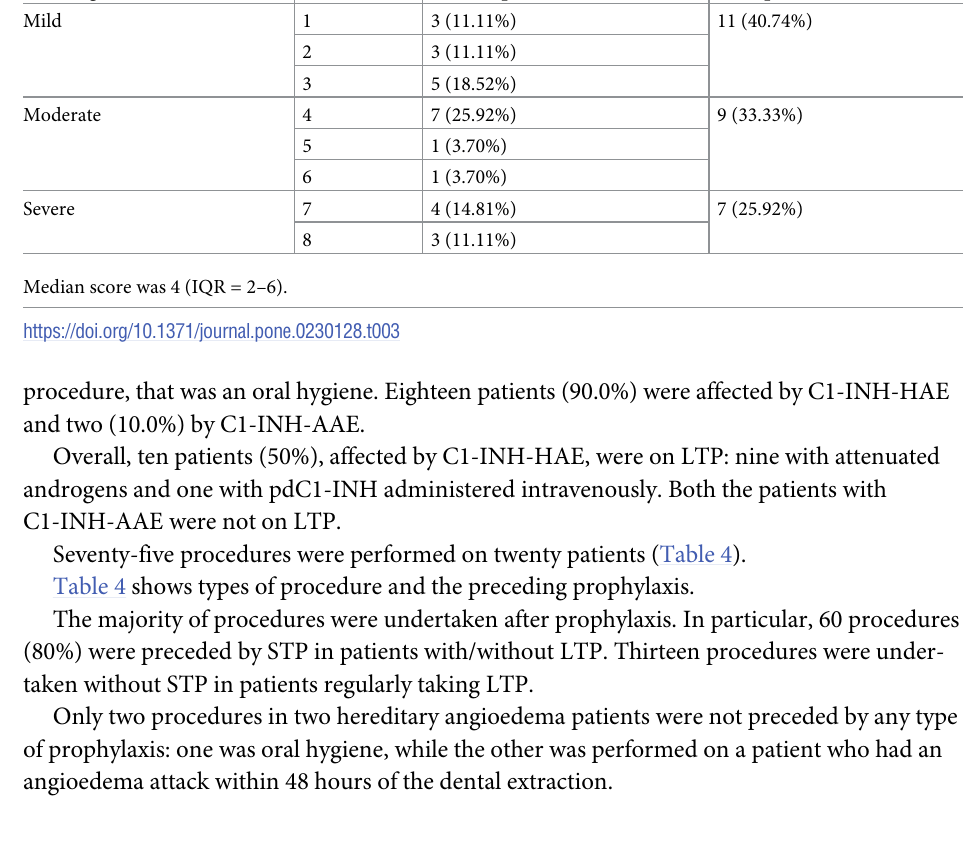
Table 3. Oral pathological status of patients (n = 27) at the first visit, based on our severity score. Pathological oral status